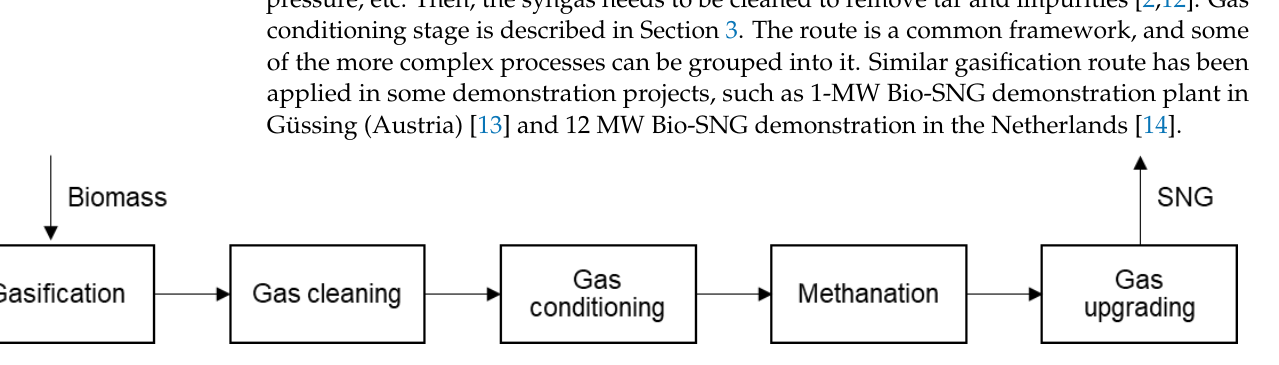
Figure 1. The process chain of SNG production through biomass gasification [1,2,6].